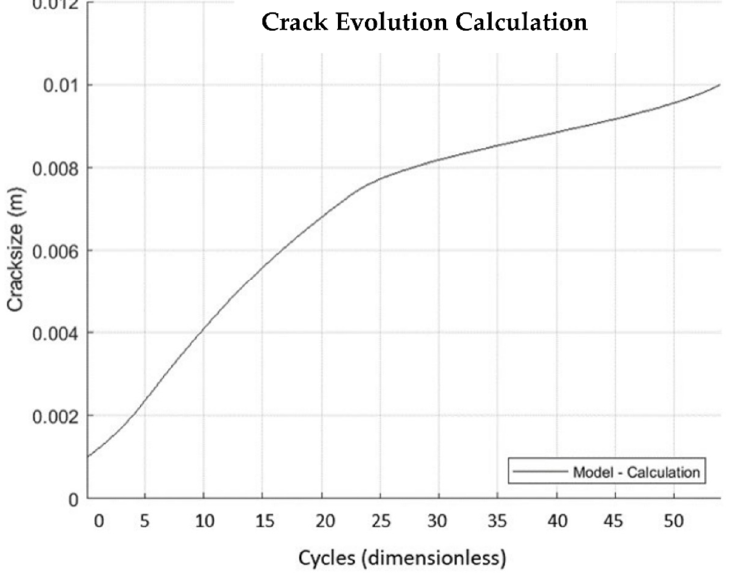
Figure 24. Crack growth evolution with the number of cycles at an operating cycle of ten firing hours.